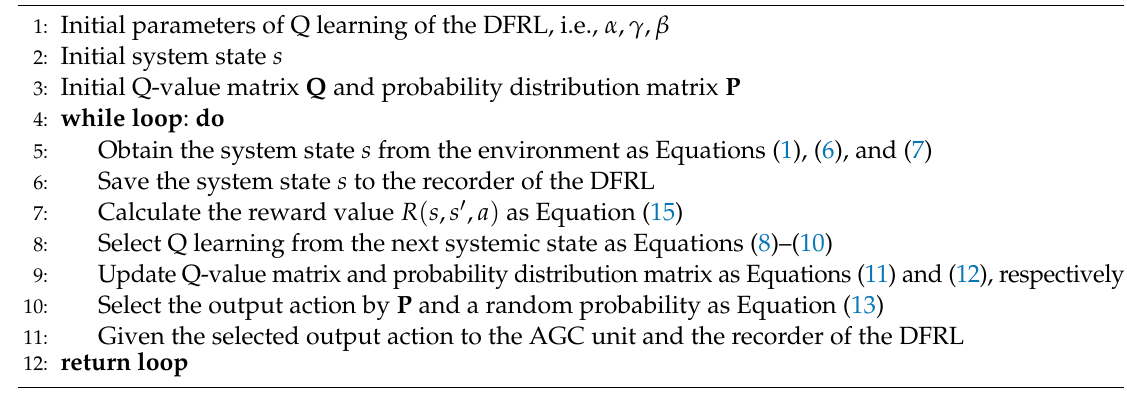
Algorithm 1 Pseudo-code of the proposed deep forest reinforcement learning for the preventive strategy for automatic generation control